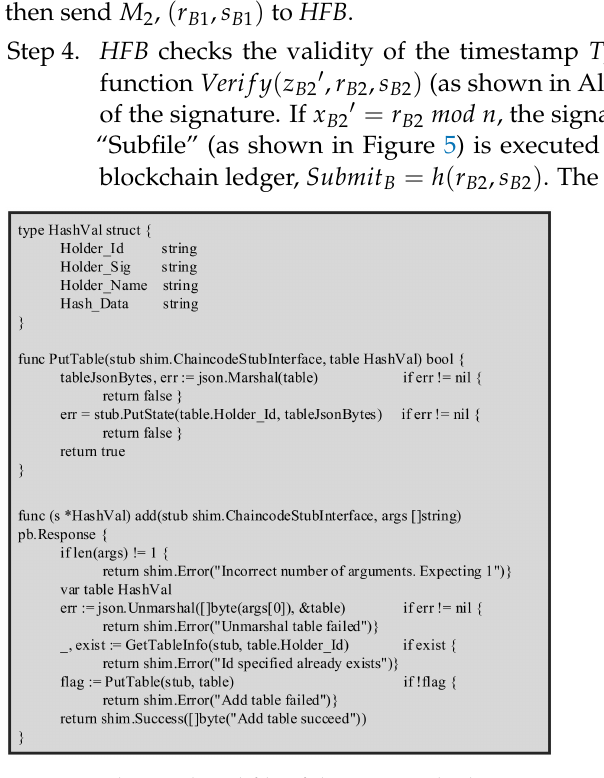
Figure 5. Chaincode Subfile of the proposed